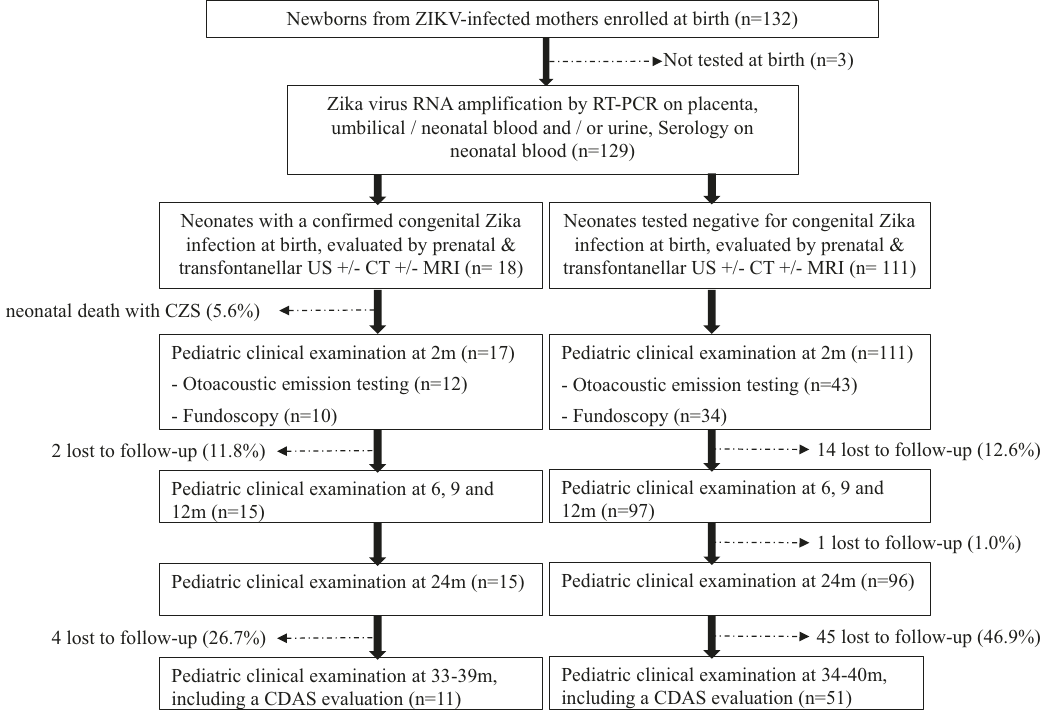
Fig. 1 Flowchart of newborns exposed to Zika virus in utero. All newborns from Zika-infected mothers, living in western French Guiana and followed at the pediatric clinic of the CHOG, were enrolled in this cohort following an informed consent process. At birth, they underwent clinical examination (including anthropometric measurements and a special focus on the neurological status), transfontanellar ultrasound (US), and testing for congenital Zika infection (PCR on urine, blood, and placenta; serology; and testing in cerebrospinal fl uid if symptomatic). After postpartum discharge, they were recalled at 2, 6, 9, 12, 18, and 24 months of life for a pediatric examination. At 3 years of life (33 – 42 months), they were recalled for an evaluation of their development using the Child Development Assessment Scale